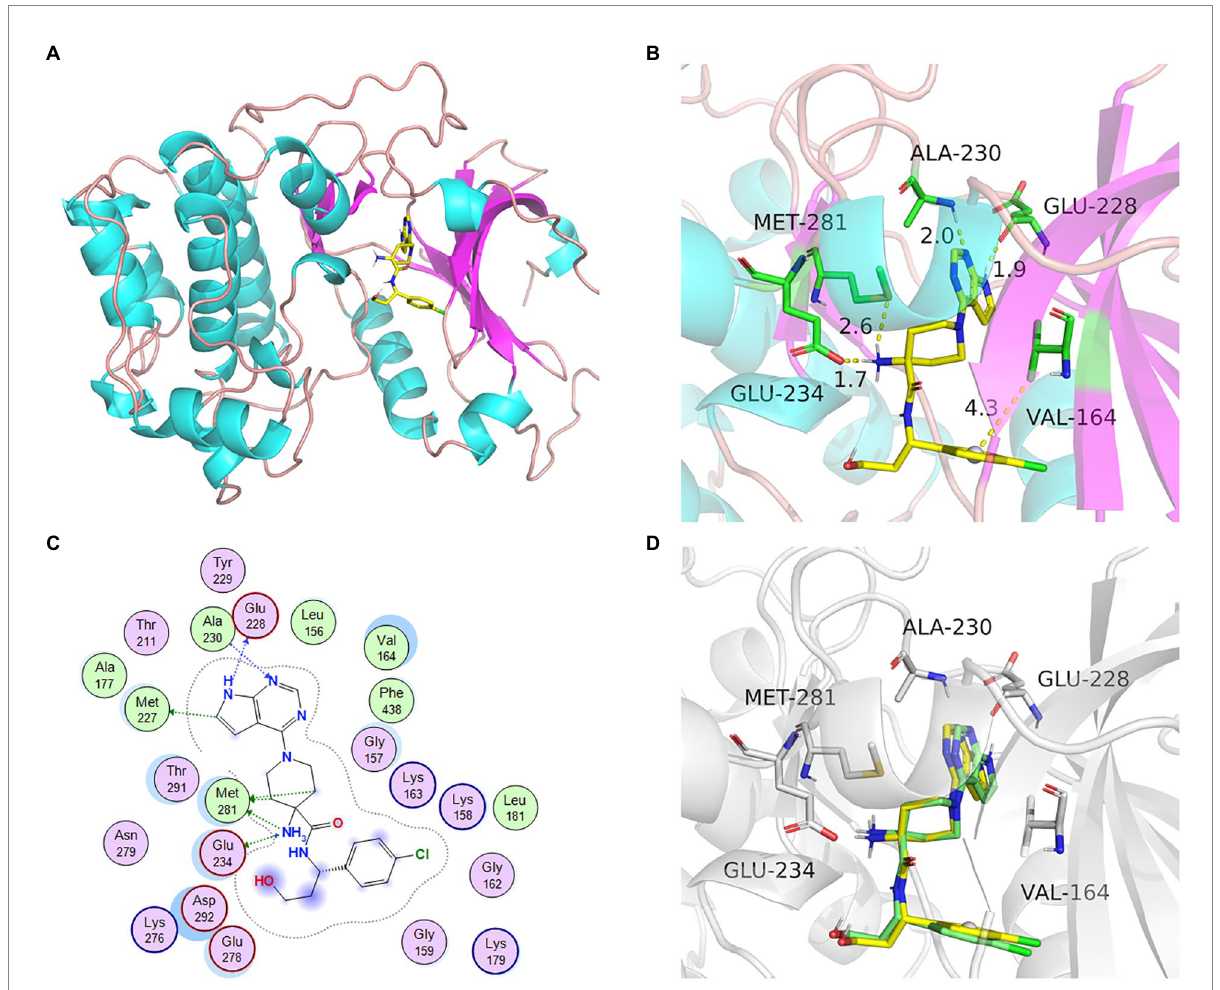
FIGURE 5 The docking model and analysis of AKT1 with natural ligand. (A) The overall 3D structure of AKT1 complex. The protein backbone was shown as a tube and colored bright blue and pink. The ligand was shown in stick and colored element. (B) A close view of the active site binding with natural ligand. Key residues interacting with ligand were shown as sticks and colored green. (C) The 2D protein-ligand interaction diagram of ligand-AKT1 complex. Protein residues were shown as circles and colored based on their properties: green, hydrophobic residue; purple, polar residue. (D) The re-docking results of active compounds with